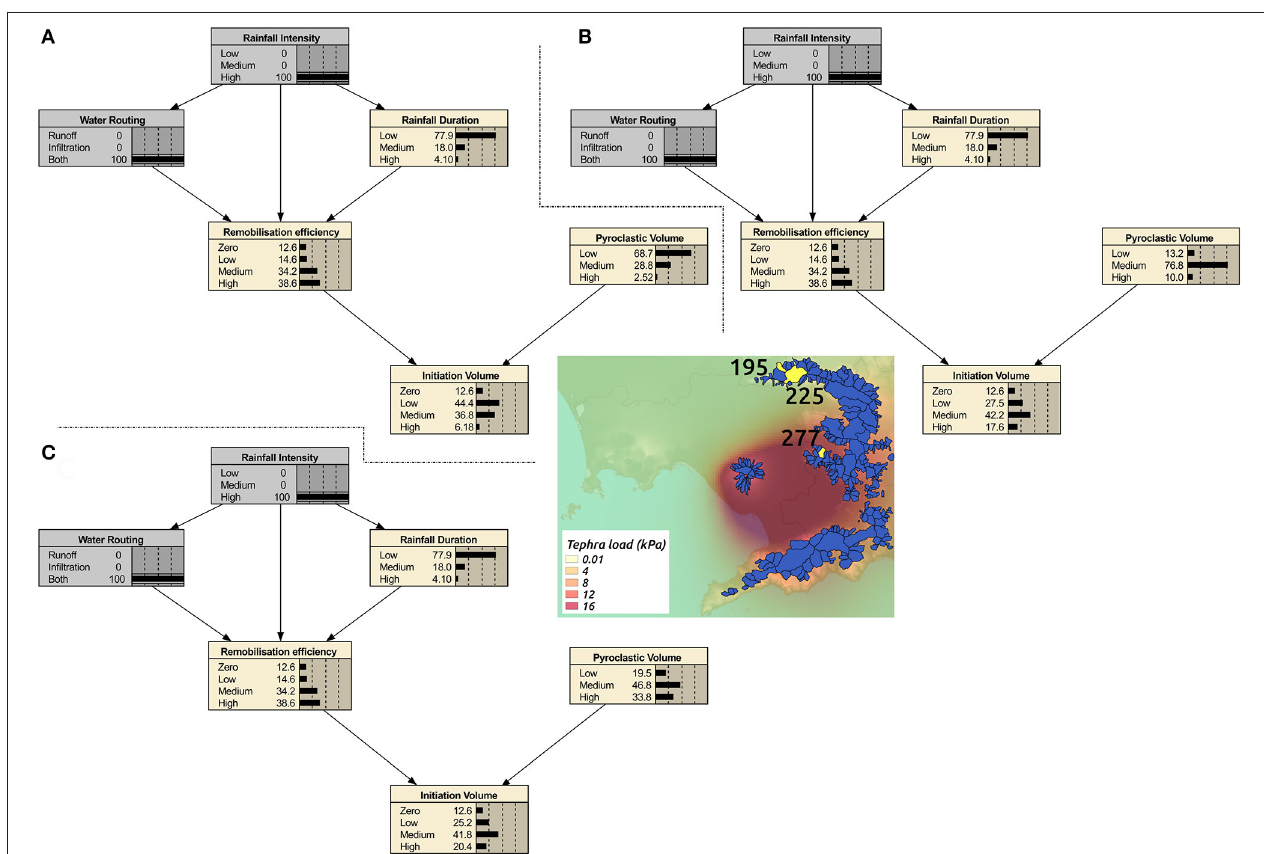
FIGURE 7 | Example of the probabilistic behavior of Multihaz implemented at Somma-Vesuvius (Italy), taking three catchments (#195, A ; #225, B ; and #277, C ) as an example of variability in catchment area and position with respect to the expected maximum accumulation of tephra (see text for more details). All the BBNs are linked to the occurrence of a large eruption and are instantiated on the RI and WR nodes to the states RI = high and WR = both (infiltration and runoff). In the map above, the catchments are highlighted in yellow. In addition, the expected tephra load (median value), given the occurrence of a large eruption, is